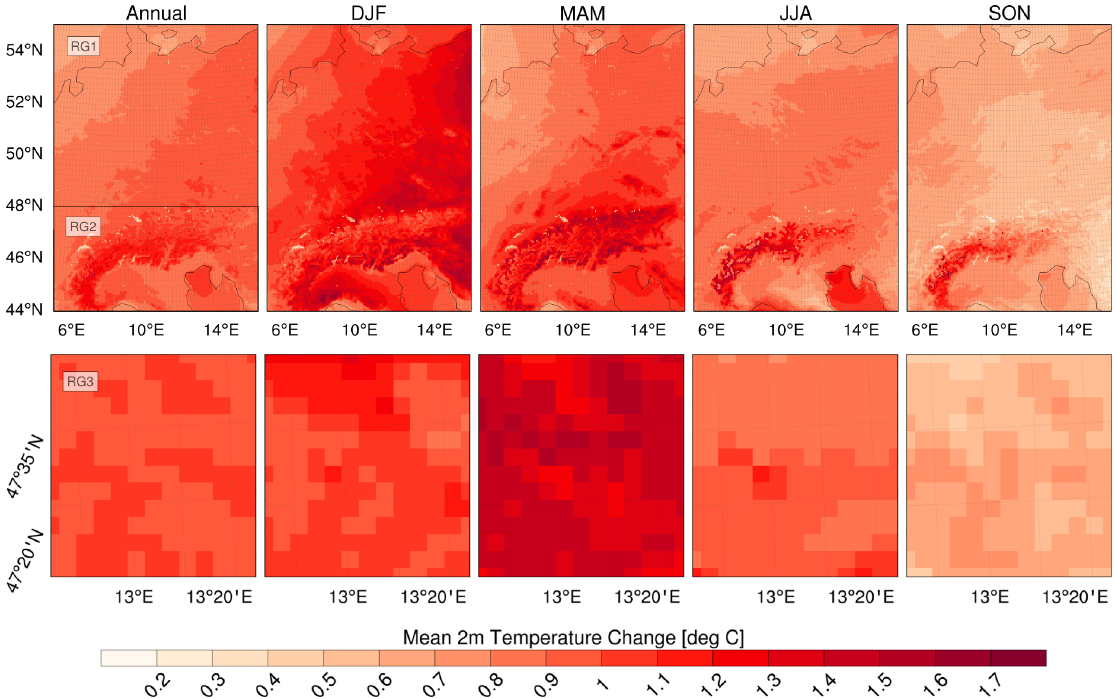
Figure 14. Projected changes 2020–2049 (scenario RCP4.5) compared to 1980–2009 for temperature for RG1, RG2 (top row), and RG3 (bottom row). Annual, winter (DJF), spring (MAM), summer (JJA), and fall (SON) changes are displayed (from left to